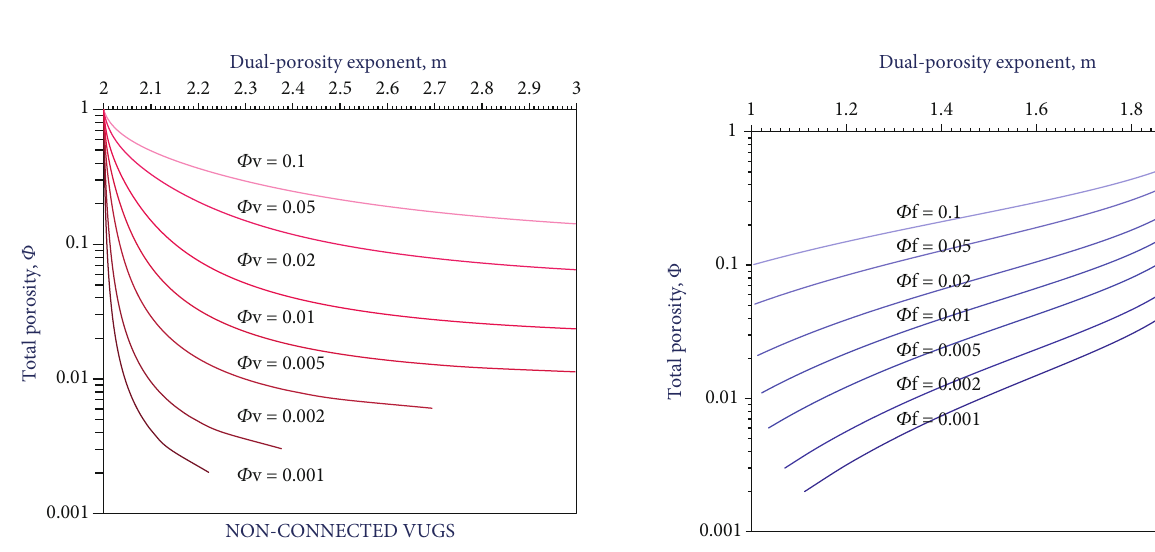
Figure 3: m determined as a function of dual-porosity media reservoirs with only matrix pores and fractures (or connected vugs) ( m = 2 ) [8]. b